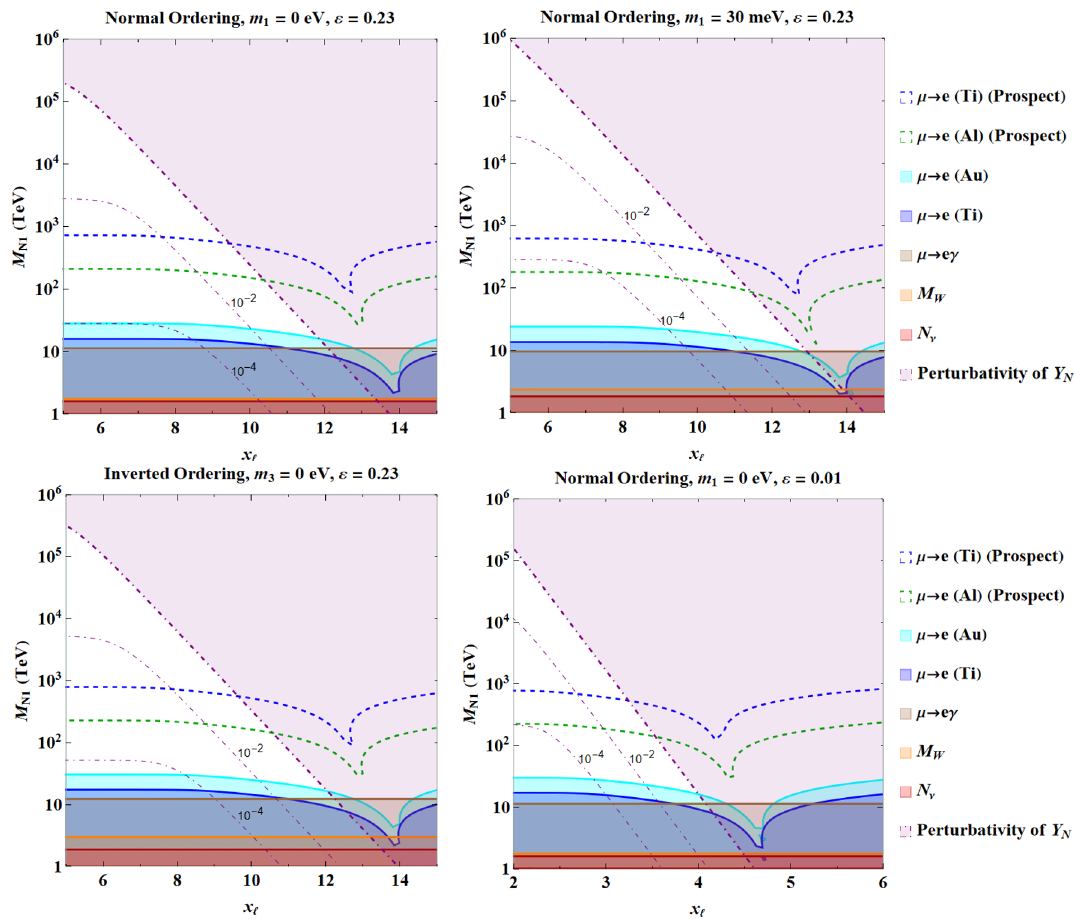
Figure 6 . Parameter space of the lightest neutral exotic lepton mass M N 1 vs. the PQ charge x ‘ . Lines and colours are explained in the legend and are the same as in figures (1) and (2). The plot on the top-left is for the NO case with a massless lightest active neutrino and ε = 0 . 23 . The one on the top-right differs from the previous one in that m 1 = 30 meV. The one in the bottom-left corresponds to the IO case with a massless lightest active neutrino and ε = 0 . 23 . The plot on the bottom-right is the only one with ε = 0 . 01 and it refers to NO with m 1 = 0